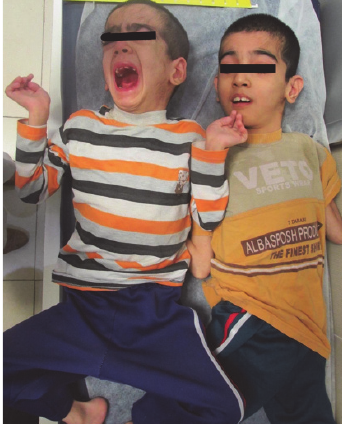
Figure 1: Two offsprings of the family, with Pelizaeus-Merzbacher Disorder. Note spastic posturing.